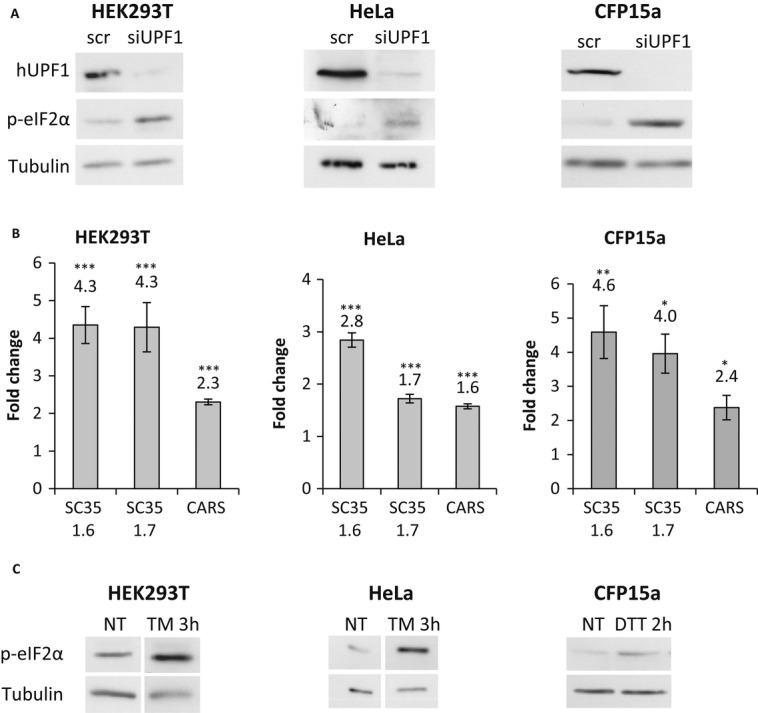
NMD inhibition activates the PERK-peIF2α UPR branch.A, B HEK293T, HeLa, and CF15a cells were transfected with siRNA against hUPF1 or nonspecific control siRNA (scr) for 48 or 72 h. (A) Protein extracts were prepared and analyzed by immunoblotting with anti-hUPF1, anti-tubulin, and anti-peIF2α antibodies. (B) Levels of SC35 1.6, SC35 1.7, and CARS transcripts were measured by RT-qPCR. The values shown are the average fold change (mean ± s.e.m.) from at least three independent experiments relative to nontreated cells or cells transfected with a nonspecific control siRNA. Values were normalized against transcripts of RNA polymerase II gene (HEK293T and HeLa) or GAPDH (CFP15a). Statistical analysis was performed using Student's t-test (one-tailed, paired). *P < 0.05, **P < 0.01, ***P < 0.001.C HEK293T, HeLa, and CFP15a cells were treated with TM (25 μg/ml) for 3 h or DTT (10 mM) for 2 h. Protein extracts were prepared and analyzed by immunoblotting with anti-tubulin and anti-peIF2α antibodies.